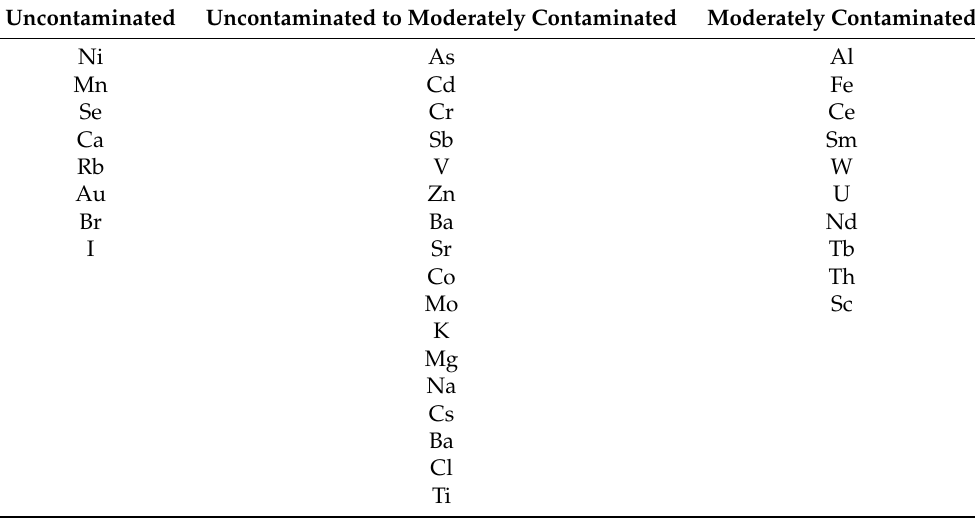
Table 5. Classification of elements according to the degree of